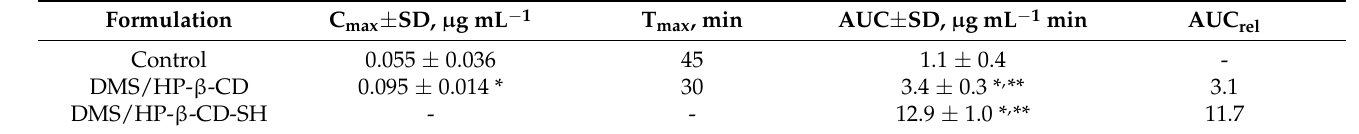
Table 2. Pharmacokinetic data in the aqueous humour following instillation of one eye drop (50 µ L) containing 0.3% w/v DMS or 0.3% w/v DMS and 12.5% w/v of different CD.